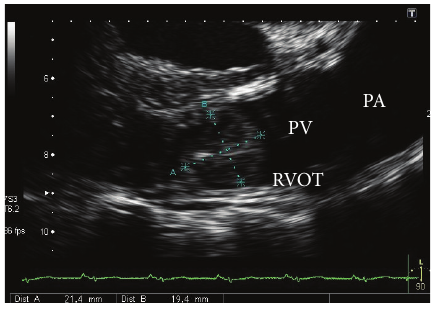
Figure 1: Transesophageal echocardiography shows the tumor in the right ventricular outflow tract. PA: pulmonary artery, RVOT: right ventricular outflow tract, and PV: pulmonary valve.